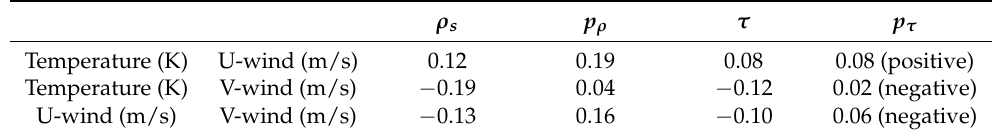
Table 4. Dependency test of the errors between weather